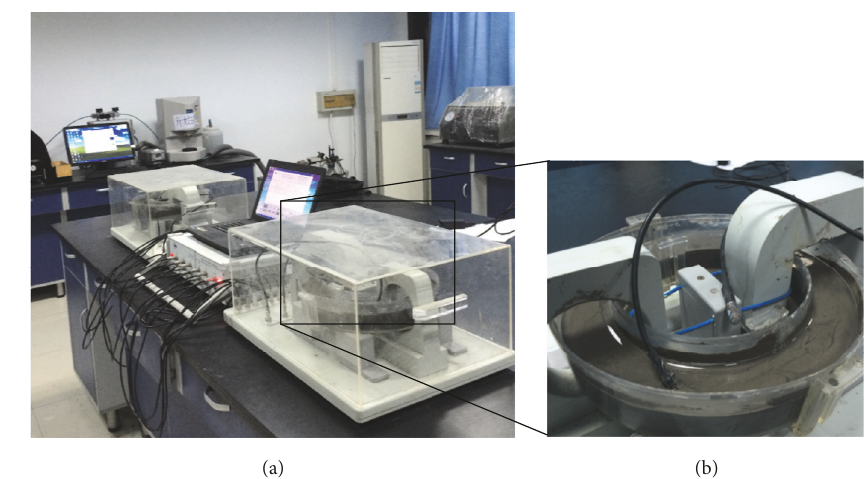
Figure 2: Electrical resistivity measurement: device and sample